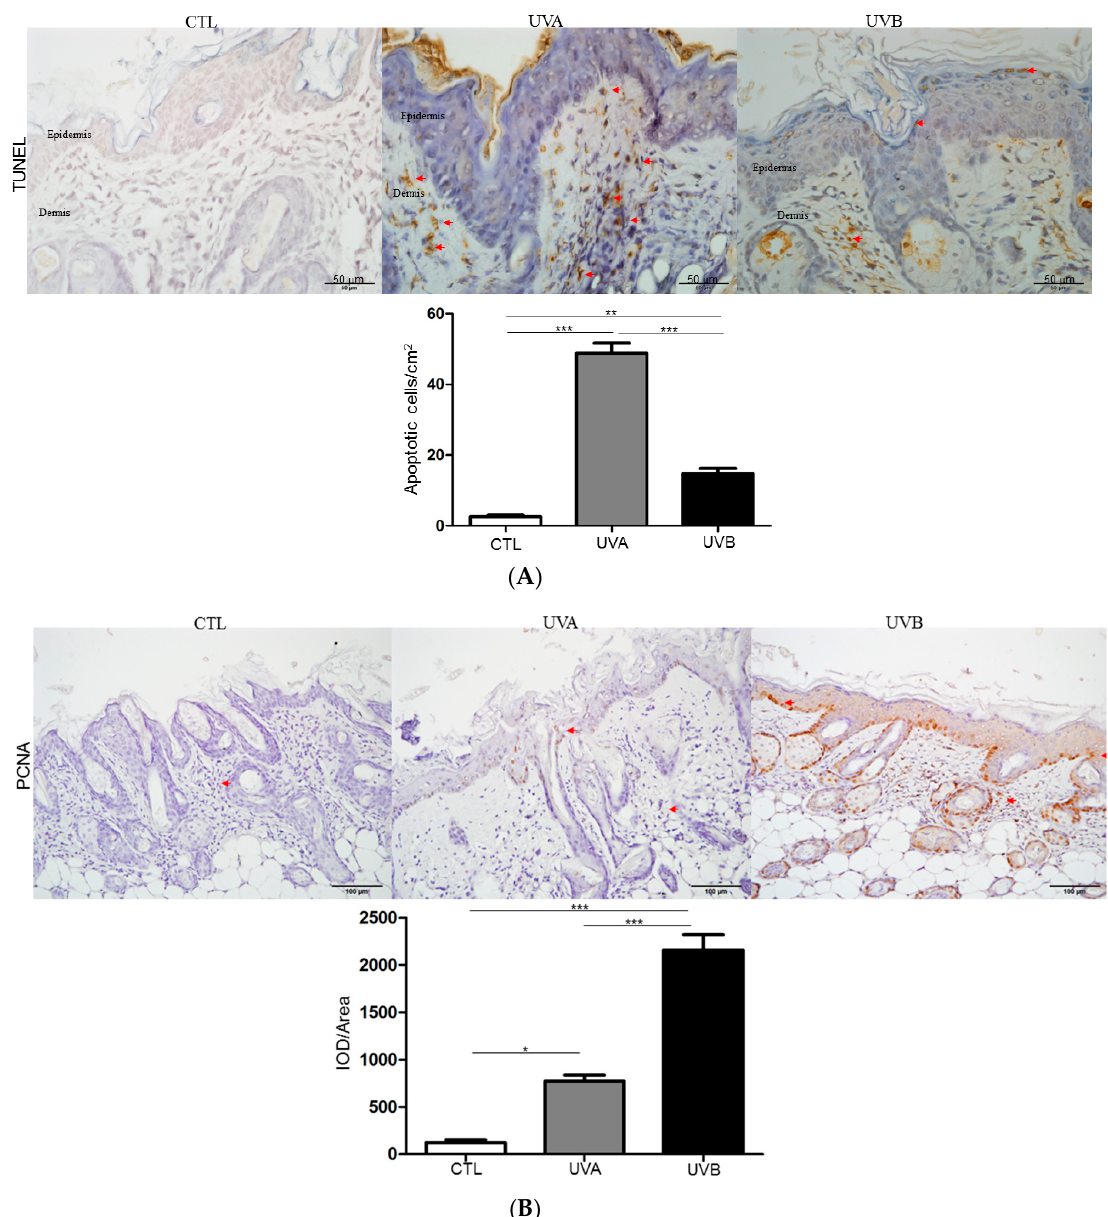
Figure 4. Investigation of the cell proliferation and apoptosis after treatment of UVA and UVB. ( A ) Terminal deoxynucleotidyl transferase dUTP nick end labeling (TUNEL) experiment was performed with immunohistochemical examination of nude mouse skin. The positive signal was indicated by the red arrows and the quantified results were indicated by the bar chart. ( B ) Proliferating cell nuclear antigen (PCNA) expression was examined with immunohistochemical staining. The regions with di ff erently expressed proteins were indicated by arrows. (* p < 0.05; ** p < 0.01; *** p <